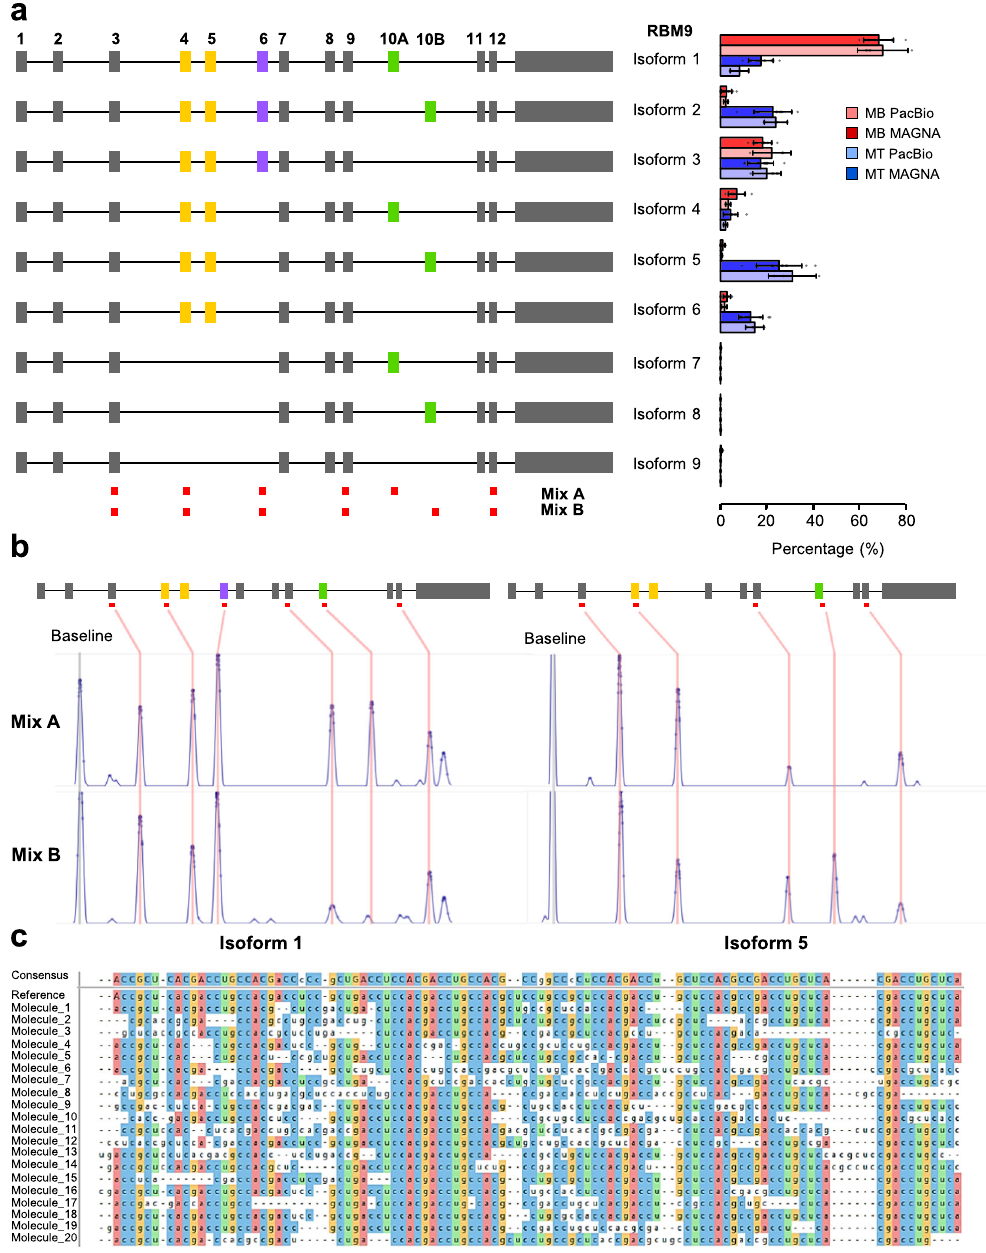
Fig. 3 Identi fi cation of alternative splicing isoforms using fi ngerprinting oligonucleotides. a A schematic showing nine different possible isoforms from mouse RBM9 transcripts. RNAs from two different cell types were used (myoblast, MB and myotube, MT), and different isoforms were quanti fi ed using the MAGNA platform or PacBio sequencing of long reads. The comparison between different identi fi cation methods, as well as changes in alternative splicing isoforms are shown on the right. b Examples of cDNA from two different isoforms generating speci fi c signatures with the two oligonucleotide mixes to differentiate transcripts with either a 10A or 10B exon. c The alignment of reconstructed sequence from 20 individual molecules of RNA and the consensus sequence obtained from these sequences, where each base in the consensus is present in more than 50% of the molecules. The expected sequence (referred as reference) is indicated. Each base within a column that corresponds to the reference sequenced is colored. The consensus sequence showed 5 errors compared to the expected reference